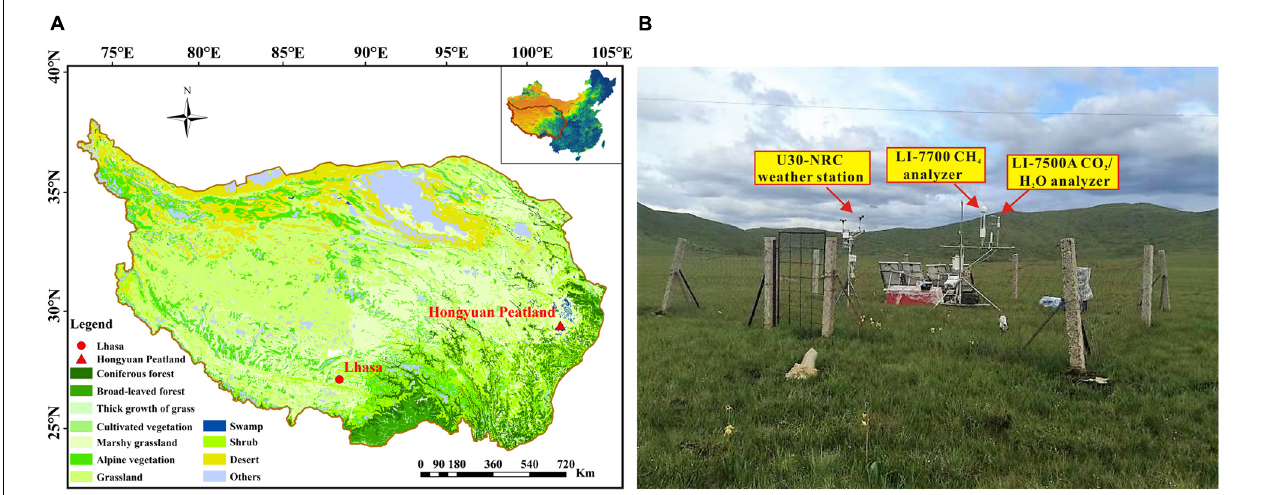
FIGURE 1 | (A) Vegetation types on the QTP. The red triangle represents the location of the site. The data was retrieved from the Data Center for Resources and Environmental Sciences of Chinese Academy of Sciences (http://www.csdb.cn); (B) Landscape and instruments at the Hongyuan Peatland Carbon Flux Monitoring and Research